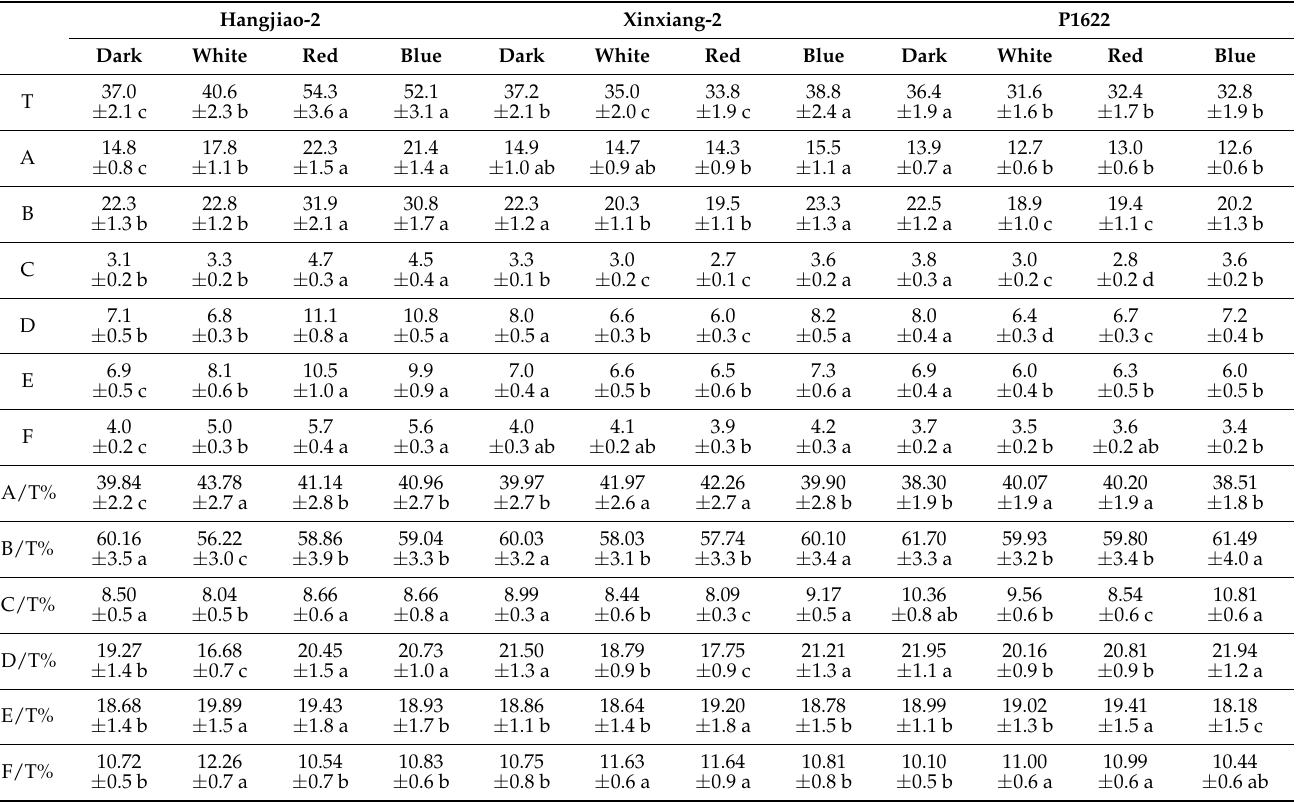
Table 2. Effect of light quality on the amino acid composition and content (g kg − 1 ) in fruits of three pepper cultivars. Hangjiao-2 Xinxiang-2